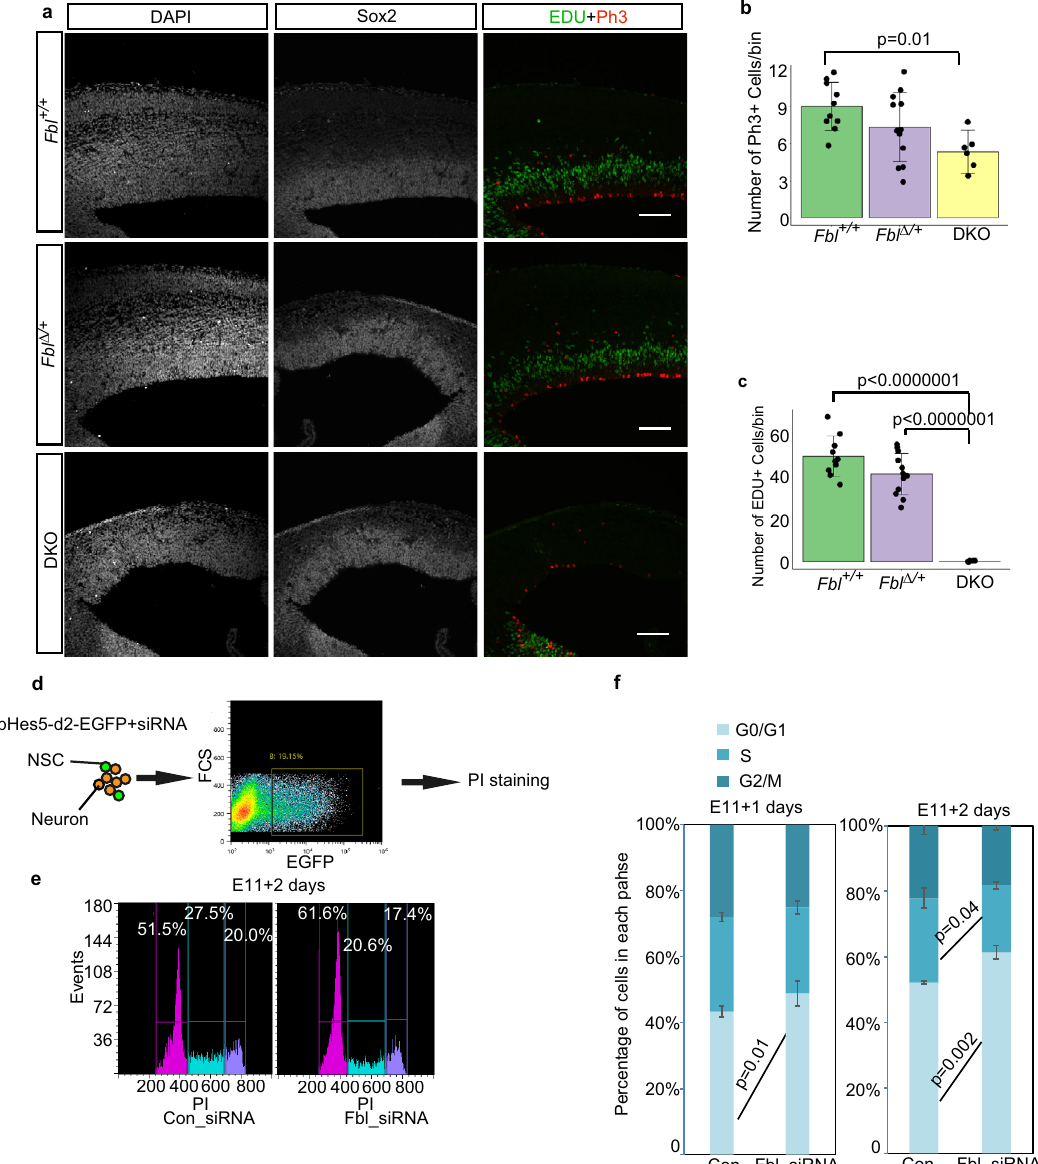
Fig. 3 Fbl is essential for cell-cycle progression. a Representative image of E14 brain sections stained for Sox2, Edu, and Ph3. Edu was injected 1 h before sampling. Scale bar: 100 µ m. b , c Cell number quanti fi cation on sections based on immunostaining with the indicated markers ( n = 5, 6, and 3 mice for Fbl + / + , Fbl Δ / + , and DKO, respectively; n = 2 sections per mouse; one-way ANOVA followed by Tukey ’ s post hoc tests; data are presented as mean ± s.d. of counted sections). d Schematics of the experimental design to investigate neural stem cell (NSC) cell-cycle progression after treatment with control or Fbl siRNA. pHes5-d2-EGFP was used to label NSCs. To sort GFP + cells, the gate was chosen to ensure the negative controls did not include GFP + cells. e Cell-cycle analysis of NSCs after Fbl knockdown. f Proportion of G1/G0, S, and G2/M-phase change after Fbl knockdown for 1 day (left) or 2 days (right) (two-sided Student ’ s t test; data are presented as mean ± s.d. of n = 3 biologically independent experiments). The gates of different cell-cycle phases were decided according to the boundary of different peaks. The gates were fi xed in all Kdm6b and Ezh2 were reduced without a concurrent decrease in mRNA levels, while the protein and mRNA levels of the NSC markers Pax6 and Sox2 were not affected (Fig. 5d, e). This dif- (Fig. 5c, Supplementary Fig. 7e, f, and Supplementary Data 3), ference was not ascribed to protein stability (Supplementary and therefore cell-cycle defects could be attributed to a lower TE Fig. 7i), thus we deduced that Fbl regulates protein translation. of those genes (Fig. 3). Interestingly, chromatin-related genes To con fi rm the Fbl affects translation of Ezh2 and Kdm6b , we were highly enriched among those with decreased TE in DKO, also performed polysome pro fi ling. Polysome pro fi ling requires a consistent with the roles of epigenetic modi fi cations in temporal large number of cells, but it is dif fi cult to collect suf fi cient patterning 35 (Fig. 5c and Supplementary Data 3). Among these, highly enriched genes were Ezh2 and Kdm6b , which encode a numbers of cells from embryonic brains. Therefore, after methyltransferase and a demethylase, respectively, of H3K27me3 fractionating the samples, we pooled the fractions corresponding (Supplementary Fig. 7g, h). We found that the protein levels of to the subpolysomes and polysomes and measured the expression